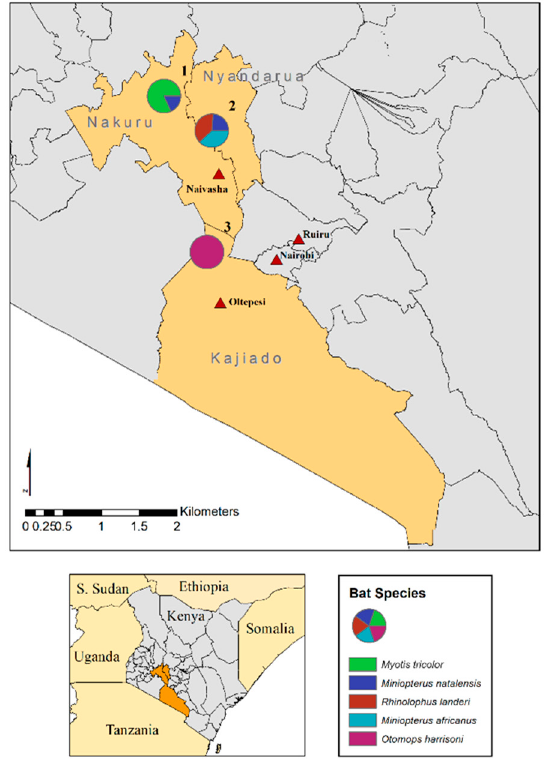
Figure 1. Map of the sites of the three bat caves and associated bat species sampled in this study: Menengai Crater ( 1 ) [ Miniopterus natalensis , Myotis tricolor ], Soysambu Conservancy ( 2 ) [ Miniopterus africanus, Miniopterus natalensis , Rhinolophus landeri ], Mount Suswa ( 3 ) [ Otomops harrisoni ].